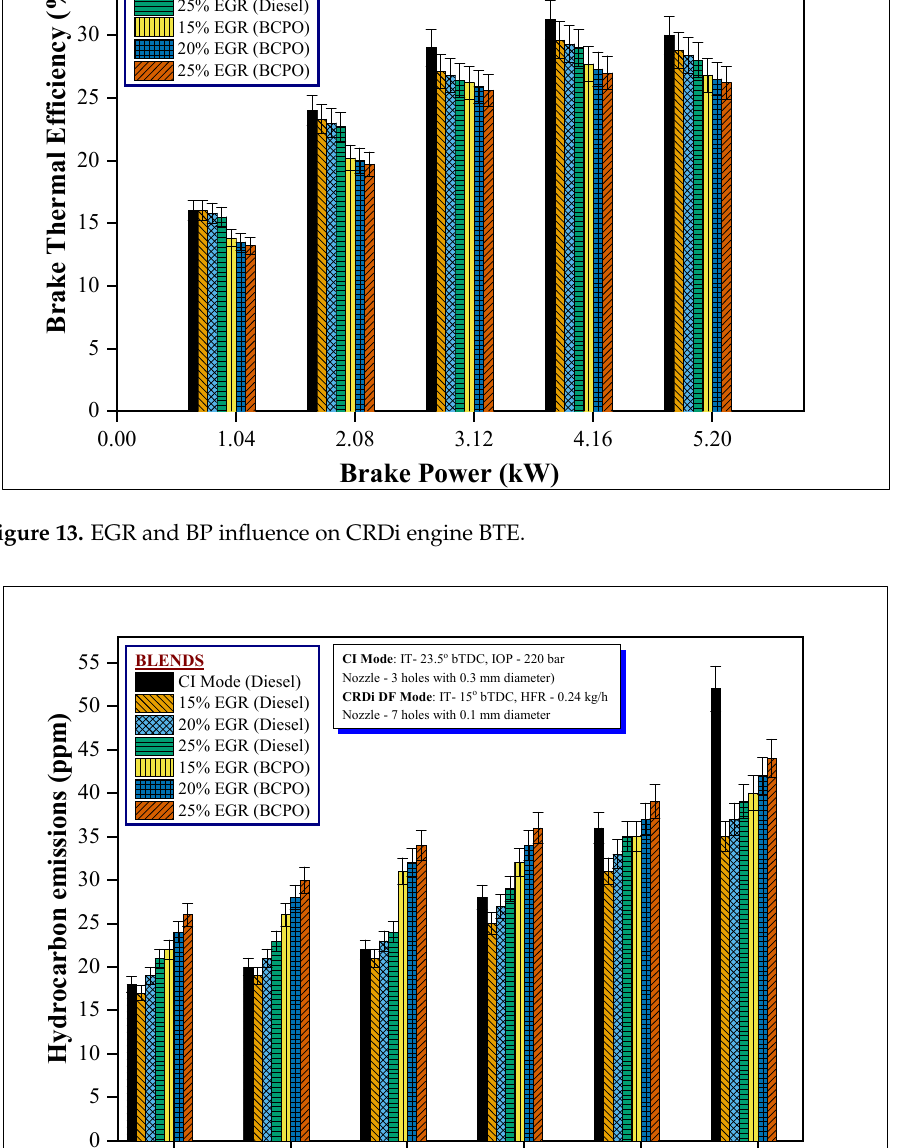
Brake Power (kW) Figure 15. EGR and BP influence on CRDi engine CO emissions.